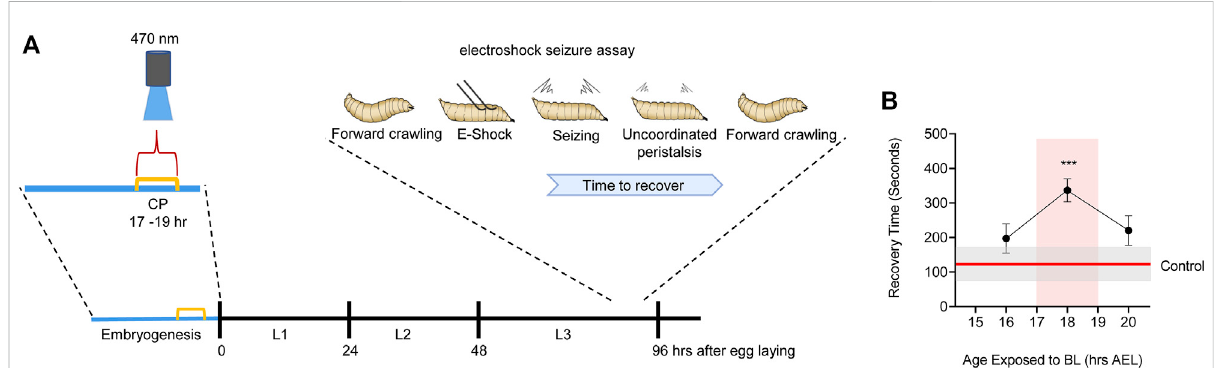
FIGURE 3 Manipulation of activity during Drosophila embryogenesis identi fi es a locomotor CP. (A) Activation of Cryptochrome-expressing neurons, by exposure to blue light (BL, 470 nm), can be exploited to increase activity in the CNS (Marley et al., 2014). Timed BL exposure localizes the embryonic locomotor CP to ~17 – 19 h AEL (at 25 ° C). (B) Timeline for blue light exposure during embryogenesis and effect to seizure-like activity in subsequent wall-climbingthirdinstarlarvae.Onlyexposuretobluelightduring17 – 19 hAELiseffectiveininducinganincreasedseizureresponse.Bluelight exposure before, or following, this 2 h window is less effective. For more details see (Giachello and Baines,